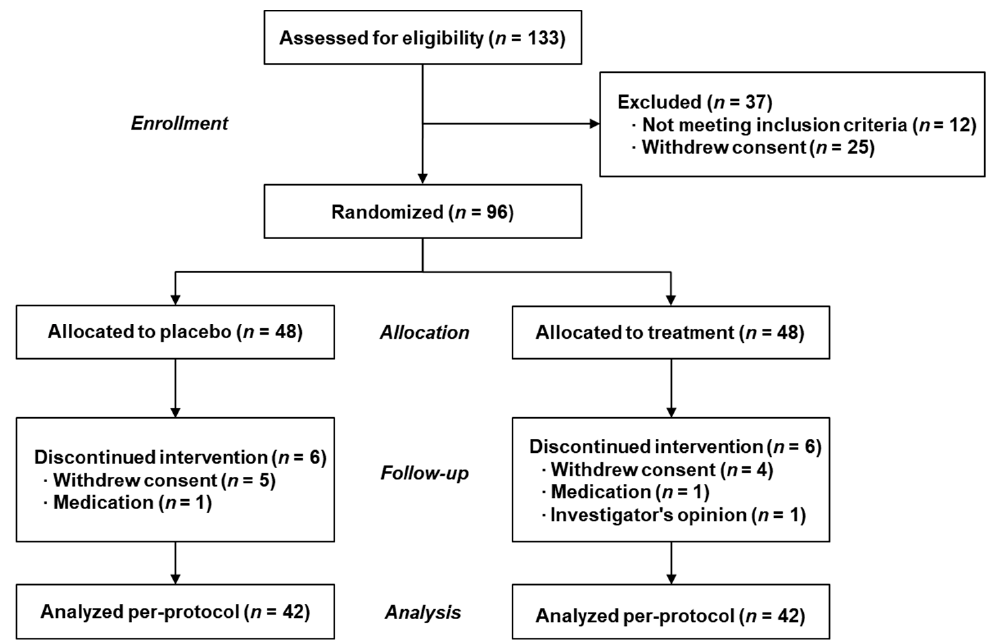
Figure 1. CONSORT flow diagram summarizing the subject’s disposition for the study.